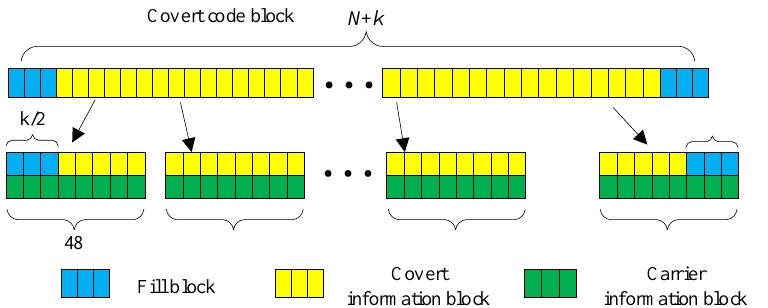
Figure 5. Symbol construction of subcarrier signal.